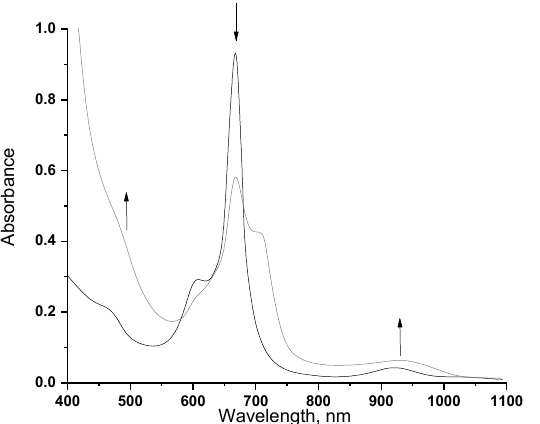
Figure 9. Changes in UV-vis for 4 in a THF solution (c = 1.6 × 10 − 5 mol/L) in the presence of bromine